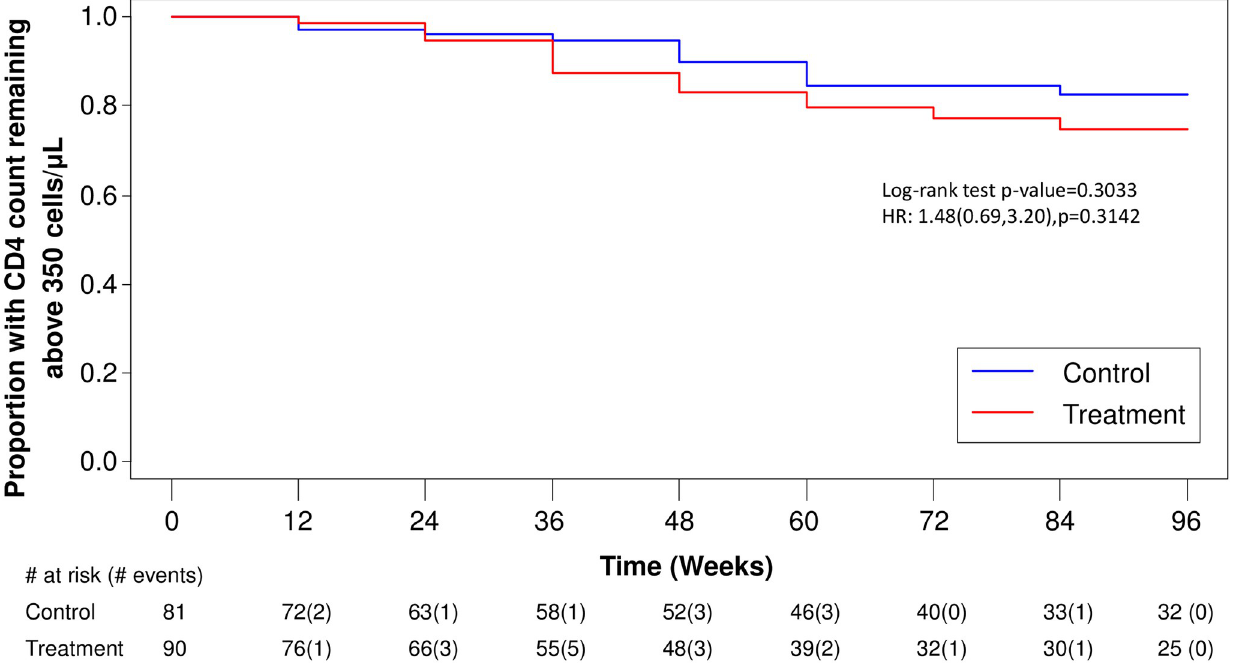
Fig 2. Kaplan-Meier Curve: Time to confirmed � ( � in 2 measures) CD4 T lymphocyte count decline below 350 cells/ μ L. Week 0 includes all individuals who were screened in and allocated to a group. The table beneath shows the individuals remaining at risk at each time point and then number of individuals experiencing an event in that interval is in brackets. There were 11 events in the Control and 16 events in the Treatment group over the study period of 96 weeks.